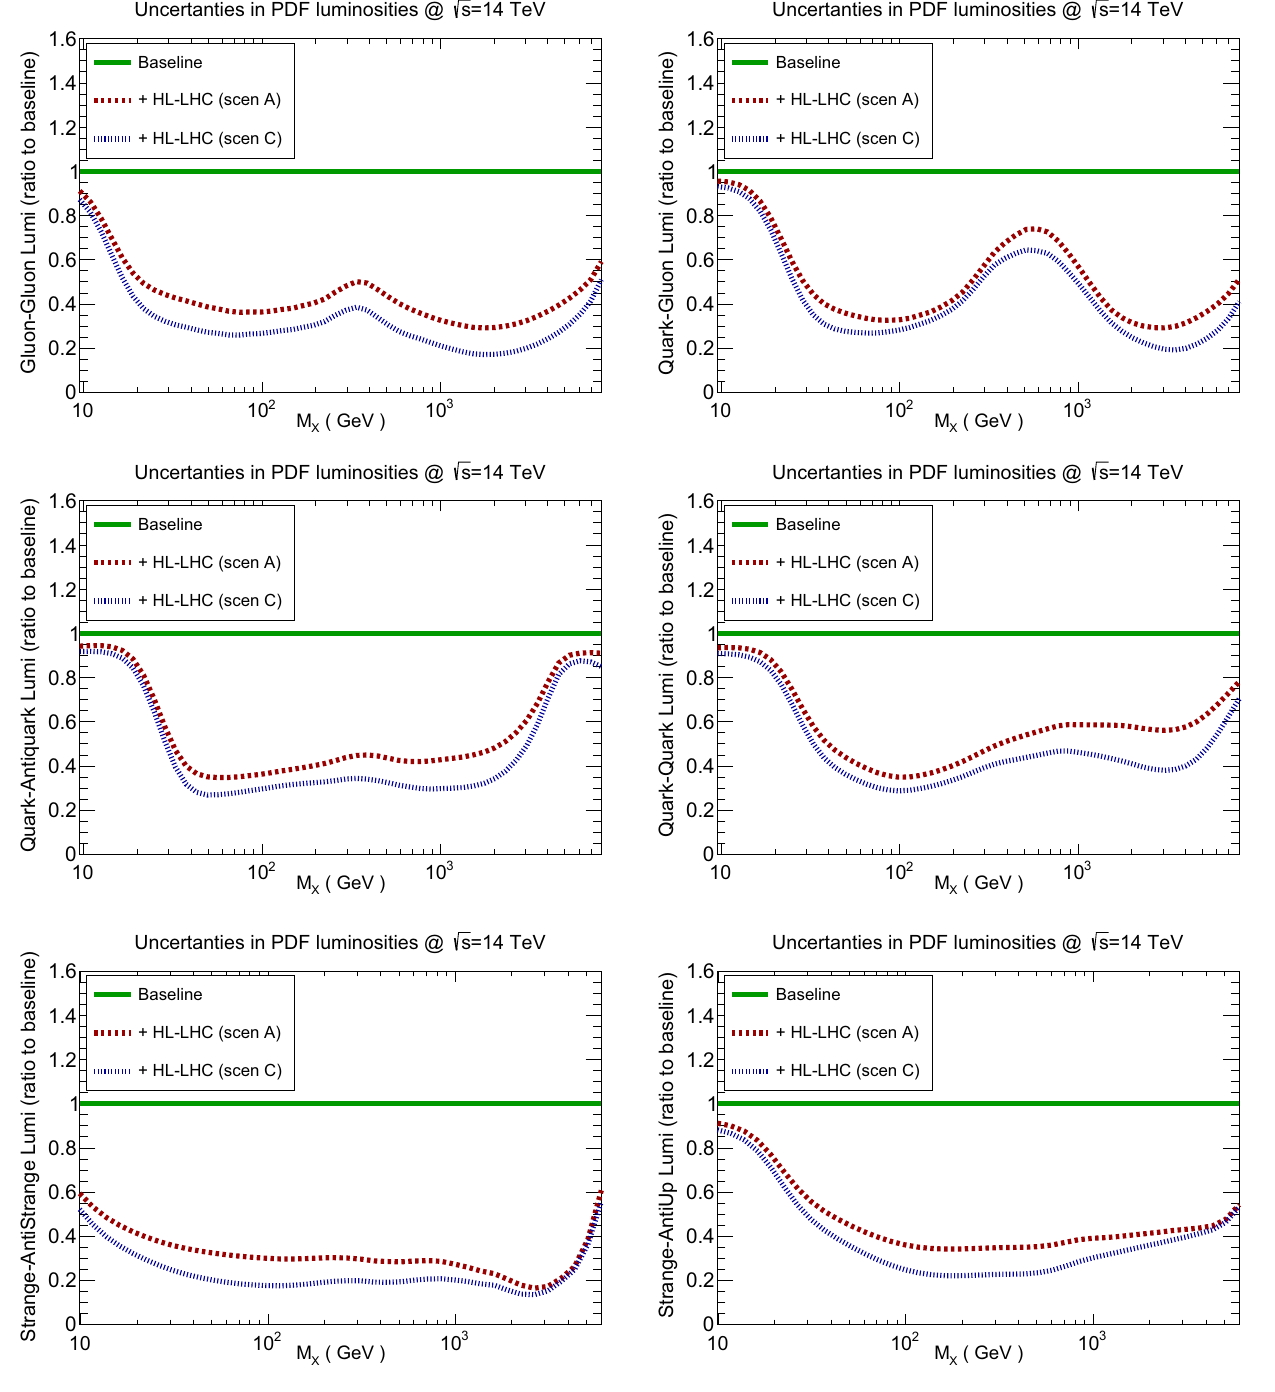
Fig. 18 The reduction of the uncertainties in the PDF luminosities at √ s = 14 TeV once the HL–LHC pseudo–data has been included, com- pared to the PDF4LHC15 baseline. We show the gg , qg , q ¯ q , qq , s ¯ s , and